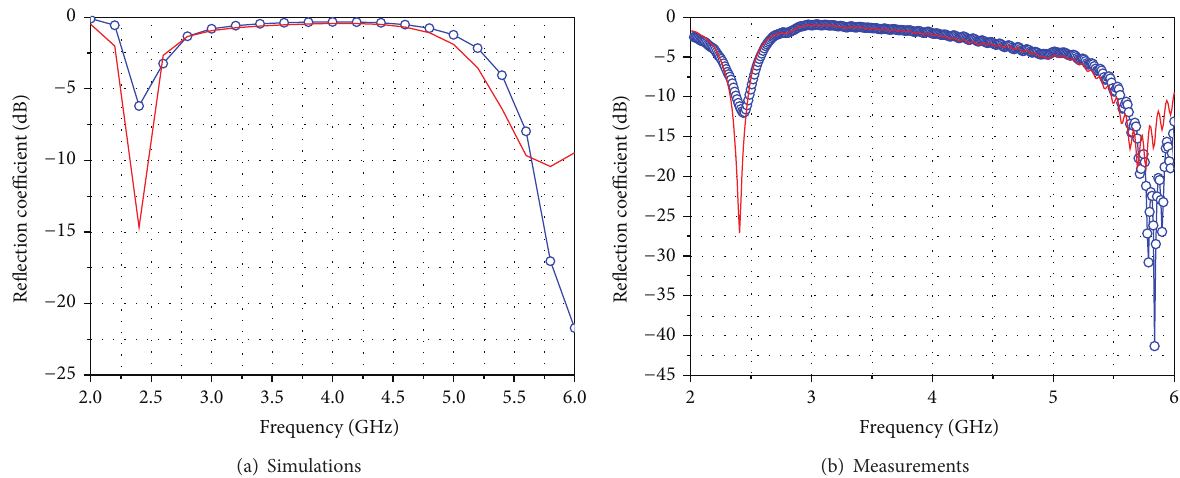
Figure 4: Reflection coefficient comparison as a function of the switch state: on-state (continuous red line); off-state (blue dashed line with circles).